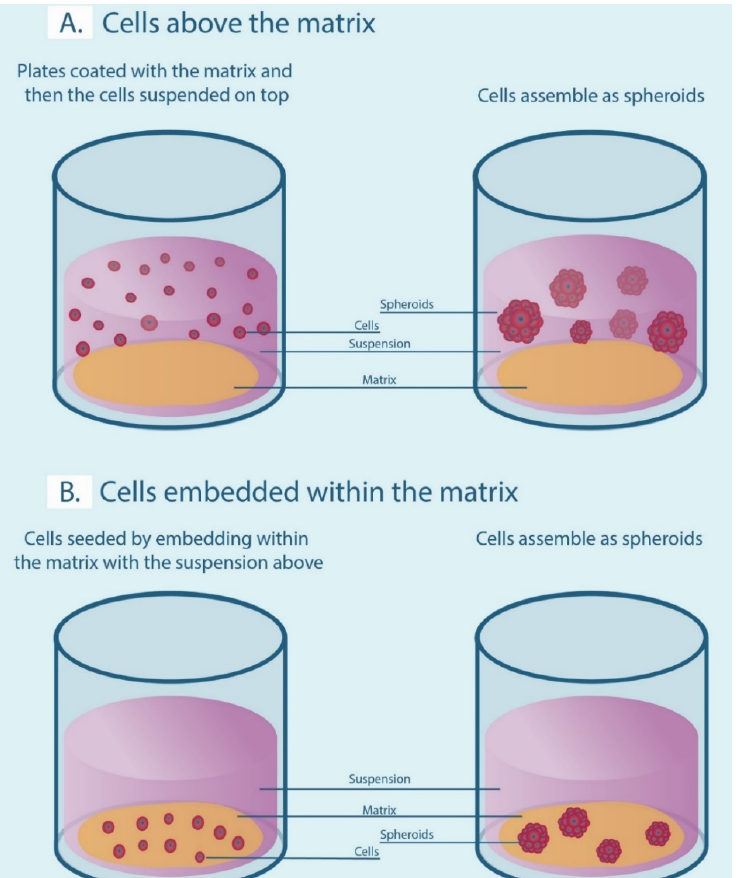
Figure 1. Principles, advantages, and disadvantages of various tumor spheroid model techniques Figure 1 (suspension based).